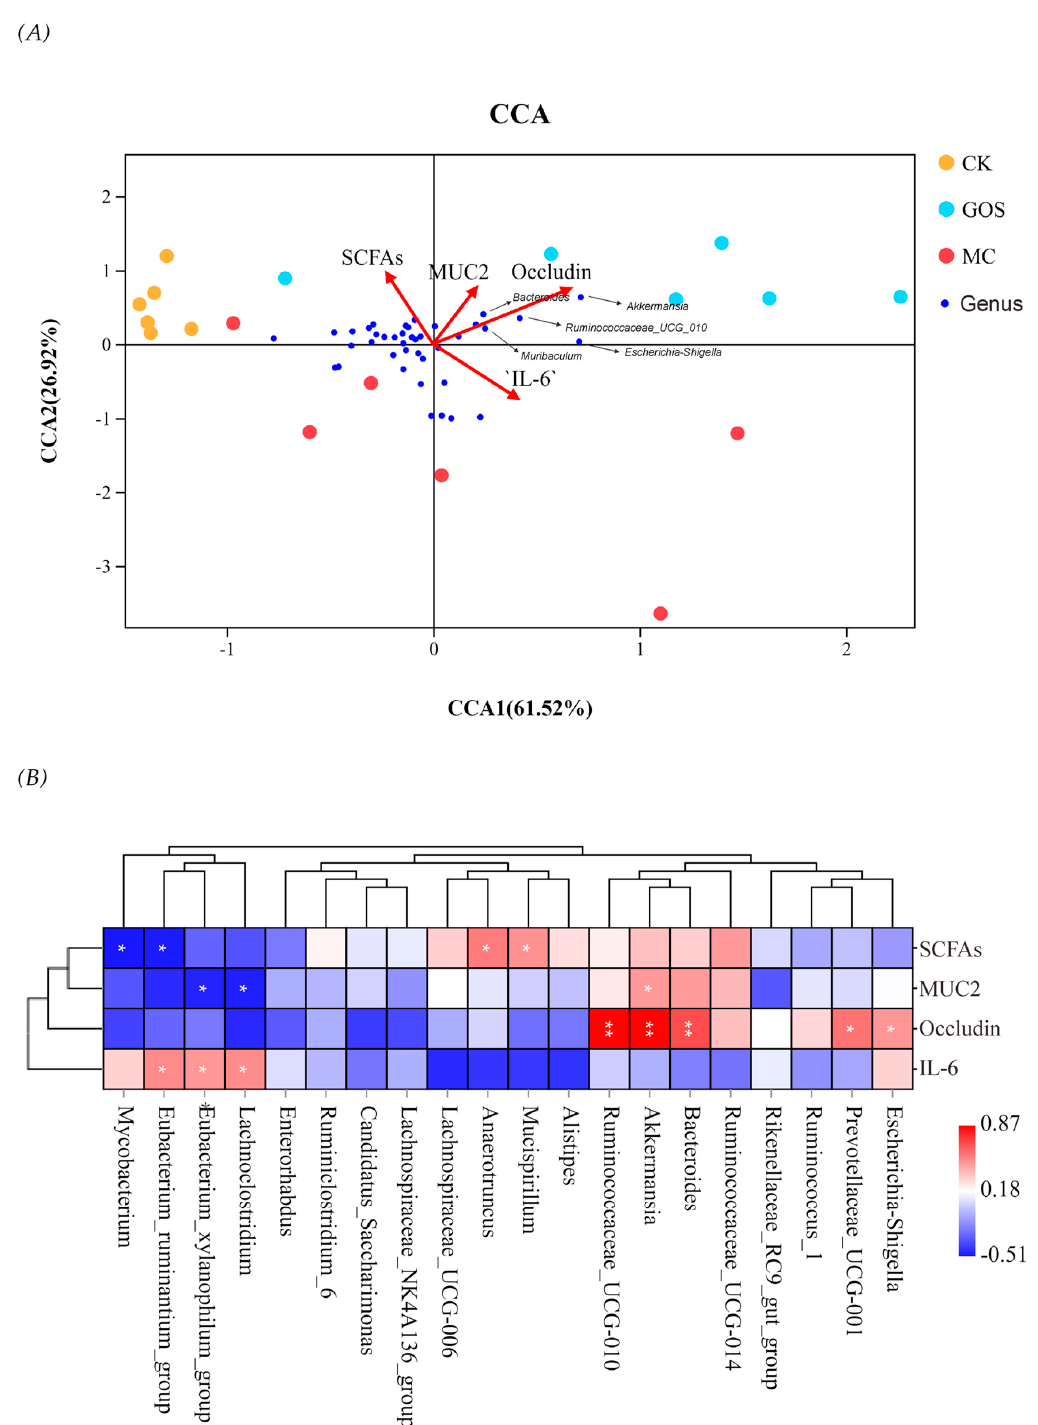
Figure 9. Correlation analysis of environmental factors. ( A ) Canonical correspondence analysis (CCA) of microbial population distribution and environmental factors. Environmental factors are marked by red arrows. The angle between the arrow lines and the sorting axis indicates the correlation between environmental factors and the sorting axis. Environmental factors with longer arrow line had a higher correlation with the distribution of intestinal flora. ( B ) As shown in the Spearman correlation thermogram, there were significant di ff erences in bacteria abundance between di ff erent environmental factors. The colors range from blue (negative correlation) to red (positive correlation). The significant correlation was expressed by * p < 0.05 and ** p <